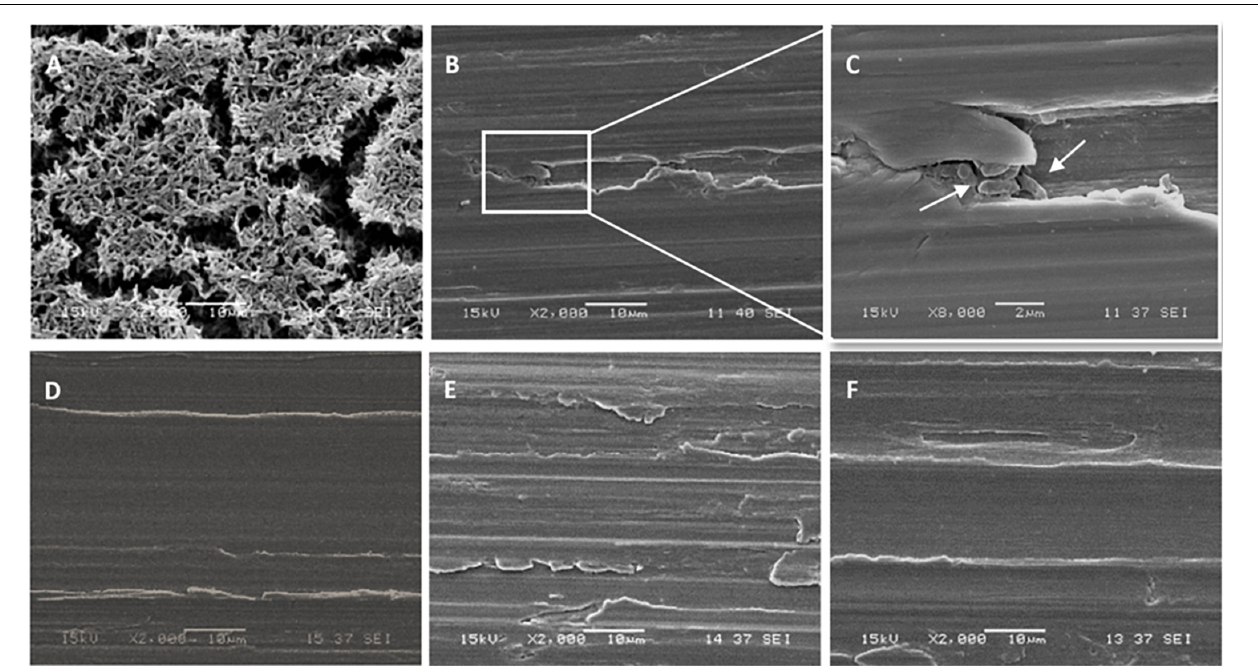
FIGURE 5 | Scanning electron micrographs of the stainless-steel slides on which P. azotoformans PFl1A biofilm was grown then removed by different sampling methods. (A) Untreated biofilm covered slide; (B) slide surface after biofilm removal using a synthetic sponge; (C) portion of B at 8,000 × magnification showing